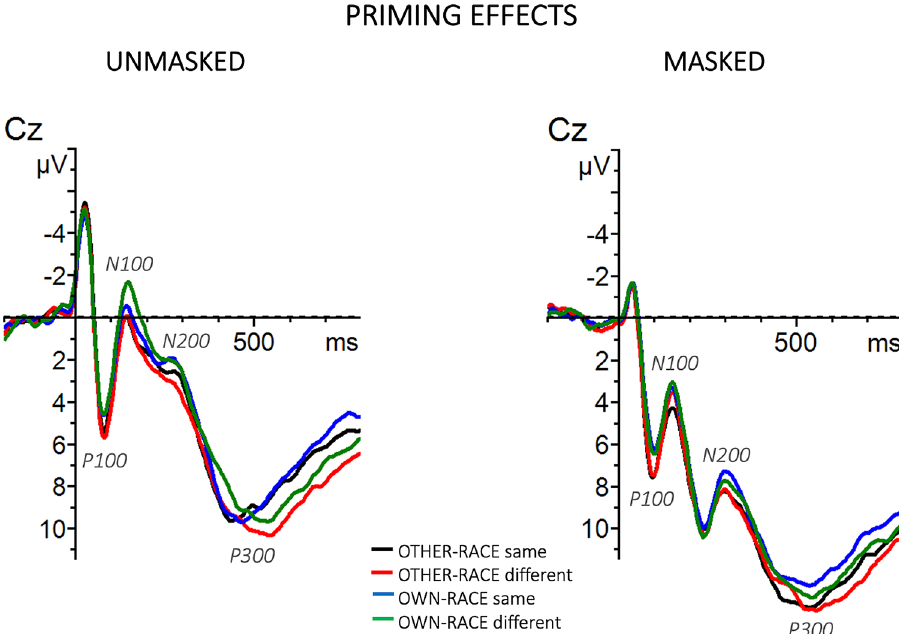
Figure 3. Grand-averaged ERP waveforms elicited by target faces separately for the unmasked (left panel) and masked (right panel) procedures as a function of prime-target identity (same vs different) and race (other-race vs